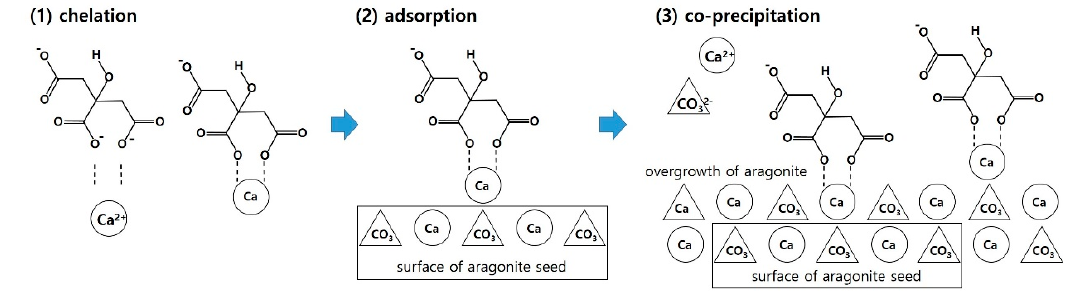
Figure 10. Schematic illustration of the incorporation mechanism of citric acid into aragonite.